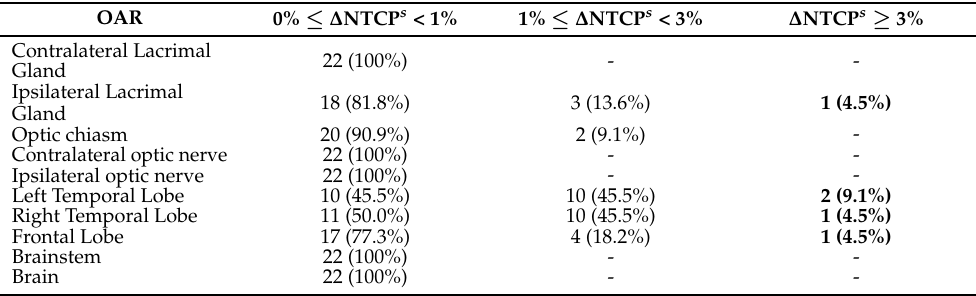
Table 5. Results for severe toxicities investigation. The number of patient cases with ∆ NTCP s higher than the selected thresholds is reported. Percentage values over the entire patient cohort is showed in brackets. Values in bold character fulfill the condition